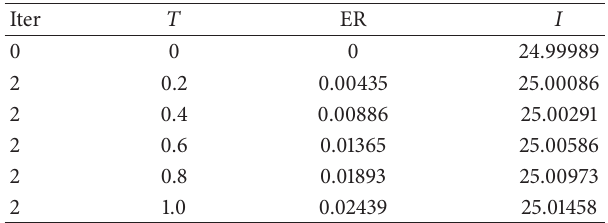
Table 1: Single soliton with 𝜎 = 0